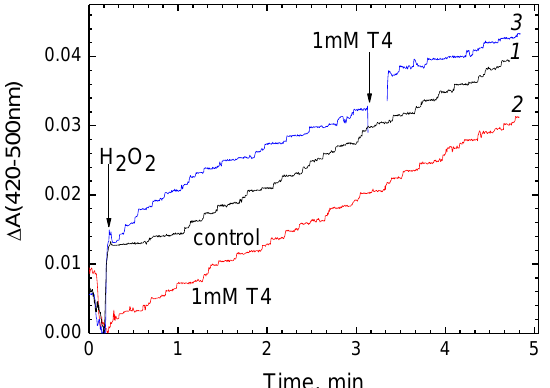
Figure 4. Peroxidase reaction catalyzed by CcO is not affected by thyroid hormones. Peroxidation of ferrocyanide (0.2 mM) was monitored in the presence of 0.6 µ M CcO. The reaction was triggered by addition of 4 mM H 2 O 2 (shown by the arrow). Trace 1 , black = control; trace 2 , red = the experiment in the presence of 1 mM T4; trace 3 , blue = 1 mM T4 added in the course of the experiment, as indicated. The initial jump on H 2 O 2 addition reflects spectral response in the γ -band of heme a 3 on oxoferryl intermediates ’ formation.